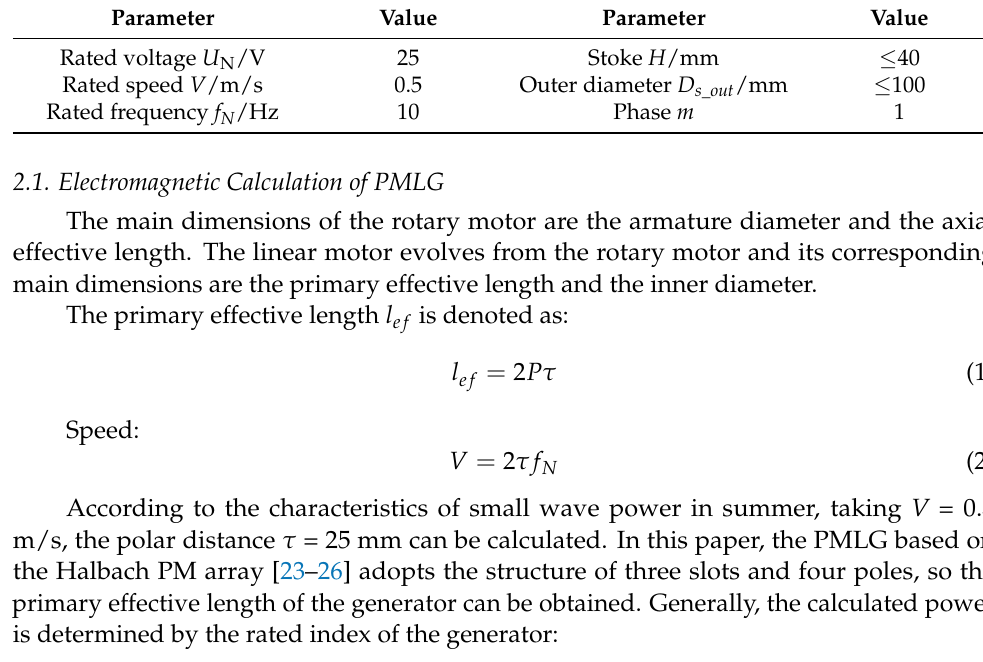
Table 1. Performance requirements of PMLG.